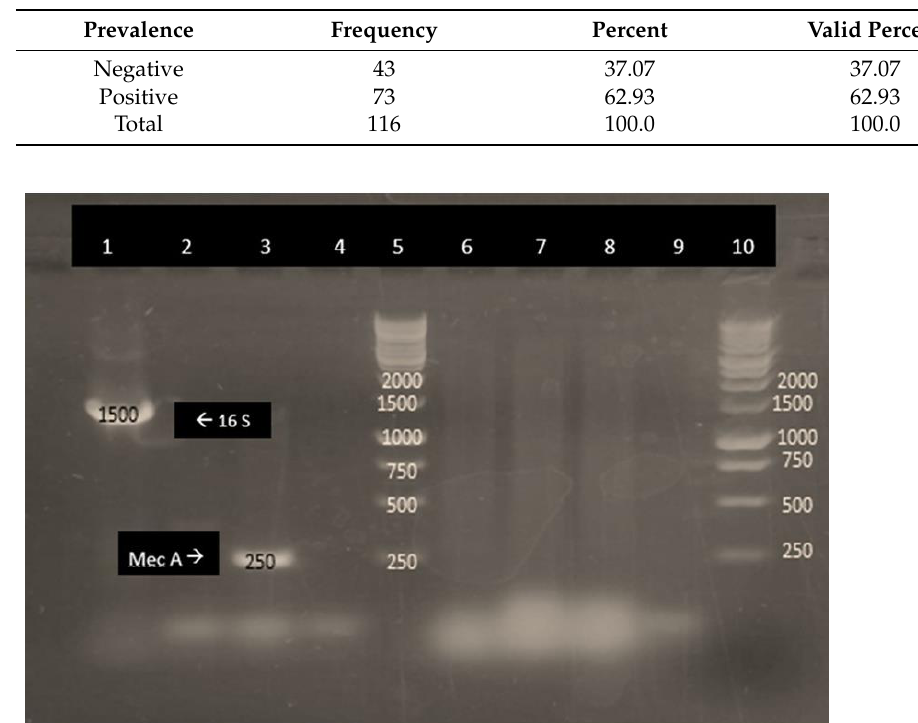
Figure 3. PCR product of the mecA gene. Lane 1 shows 16 S rDNA PCR product. Lane 2 presents mecA gene amplification from MRSA isolates while 3, 4, 6, 7, 8, 9 present results from Methicillin sensitive strains. Lanes 5 and 10 have ladder of 1 kb (Promega, Madison, USA).